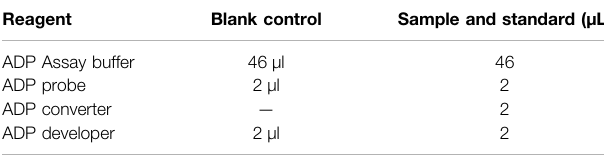
TABLE 1 | The reaction solution for ADP